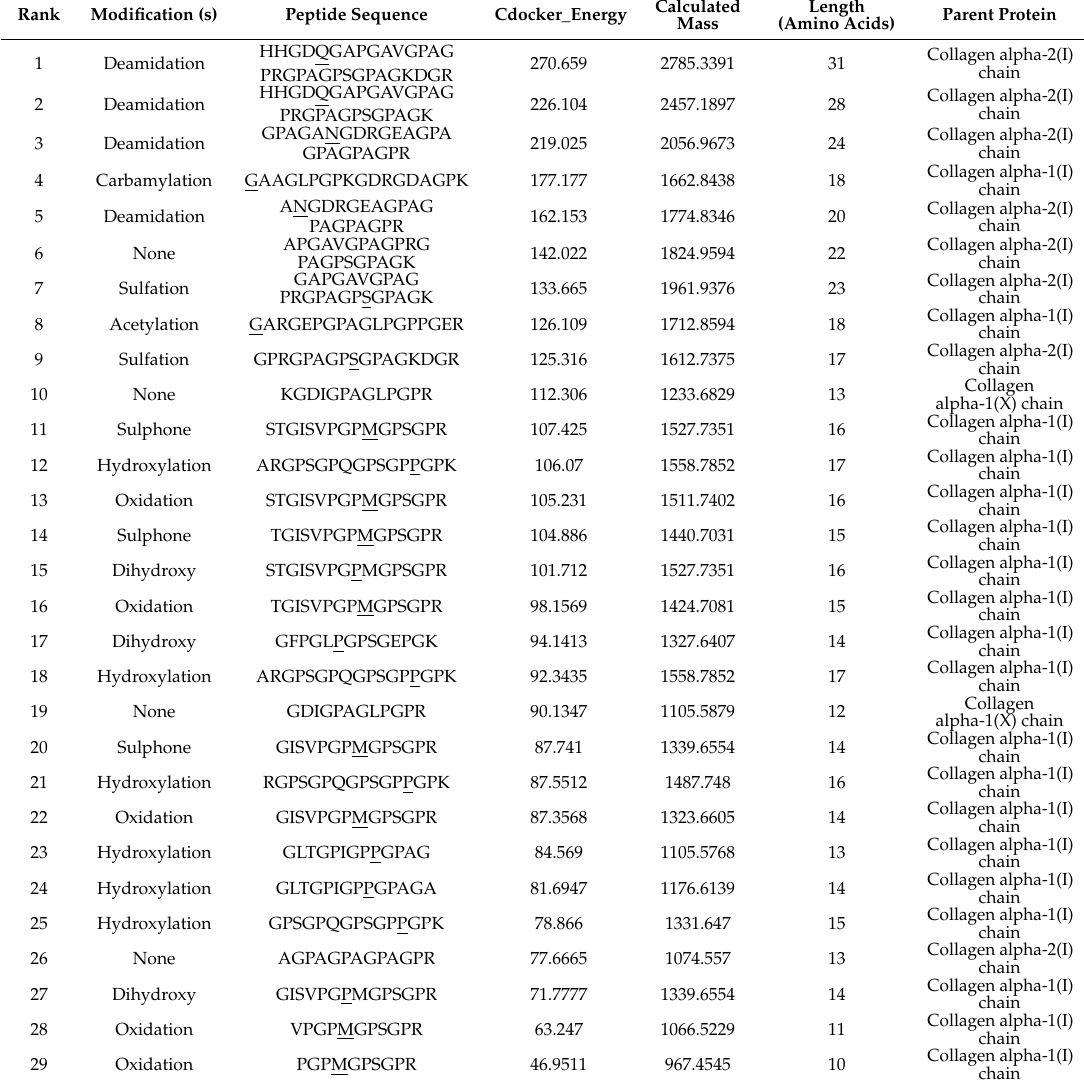
Table 1. Molecular peptide profiles from the bovine bone collagen hydrolysate (BBCH)-1 fraction as identified by